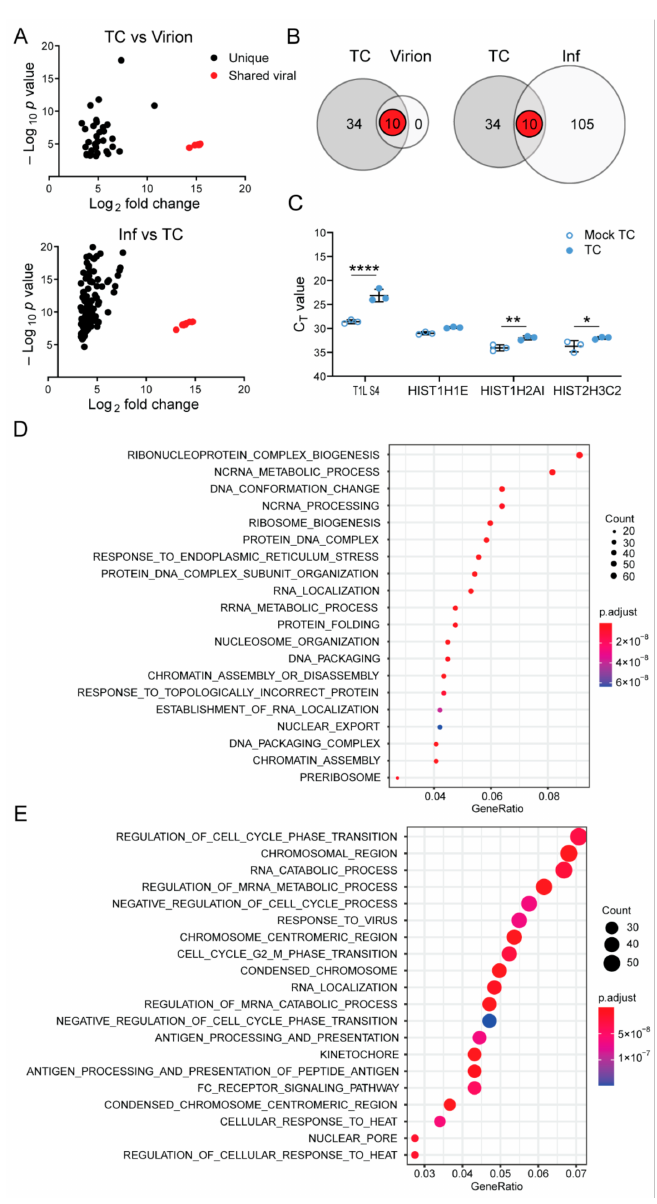
Figure 4. Reovirus rsT1L TC particles package host RNA. ( A ) Graphs showing host genes packaged by rsT1L TC that have a p value < 0.01 and fold change > 8 compared with mock TC. Red indicates shared viral genes between rsT1L TC and virions (upper) or rsT1L-infected L cells (lower). ( B ) Venn diagrams showing overlap in host genes with a p value < 0.01 and fold change > 8 between rsT1L TC and virions (left) or between rsT1L TC and rsT1L-infected L cells (right). Red indicates shared viral genes. ( C ) RT-qPCR validation of significant viral and host genes in TC compared with mock TC. RNA was extracted from three independent, protein-normalized rsT1L TC particle preparations and equal volumes of contemporaneously purified mock TC preparations. cDNA was reverse